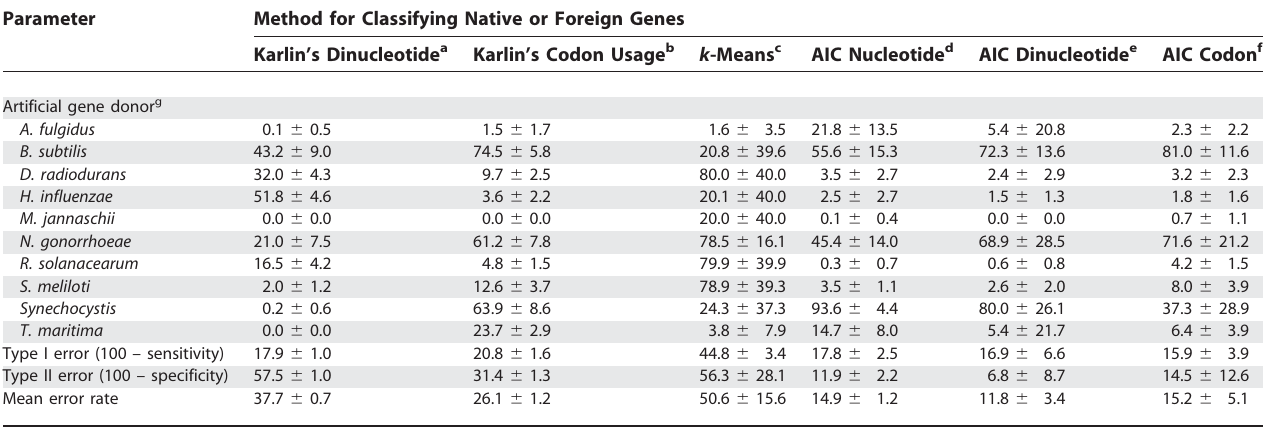
Table 1. Error Rates of Parametric Methods for Detecting Atypical Genes in an Artificial E. coli Genome Parameter Method for Classifying Native or Foreign Genes